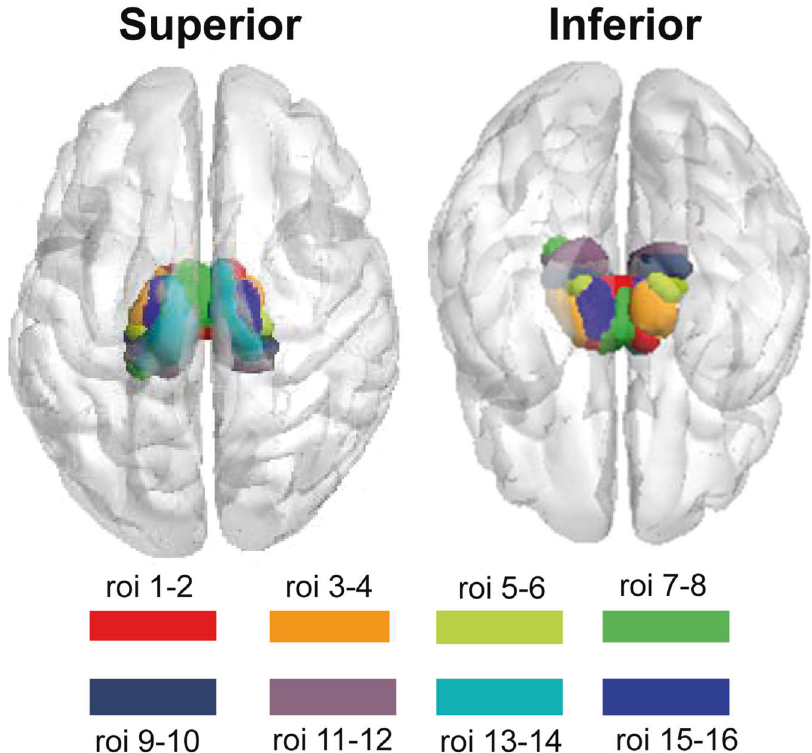
Fig. 1 The anatomical location of thalamus subregions. The thalamus subregions containing the medial prefrontal thalamus (mPFtha, roi1, and roi2), the pre-motor thalamus (mPMtha, roi3, and roi4), the sensory thalamus (Stha, roi5, and roi6), the rostral temporal thalamus (rTtha, roi7, and roi8), the posterior parietal thalamus (PPtha, roi9, and roi10), the occipital thalamus (Otha, roi11, and roi12), the caudal temporal thalamus (cTtha, roi13, and roi14), and the lateral pre-frontal thalamus (IPFtha, roi15 and